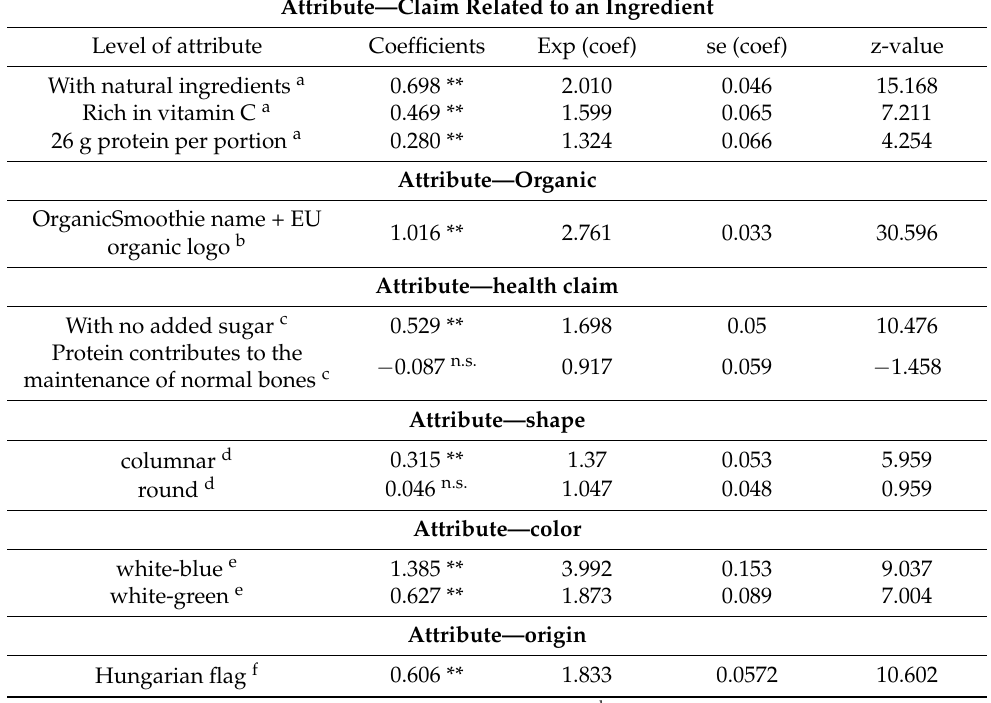
Table 2. Results of the conditional logit model.